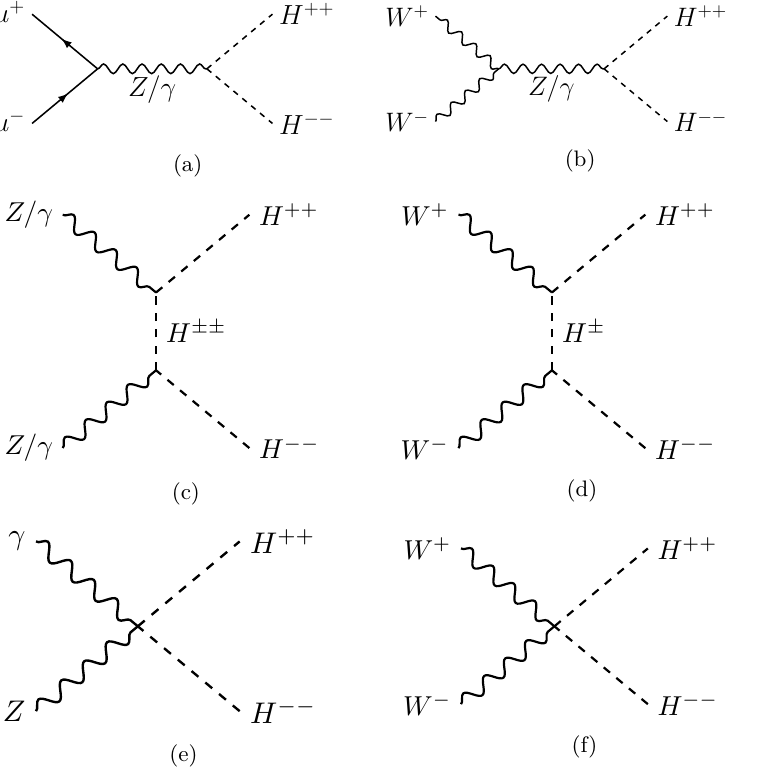
Figure 6 . Feynman diagrams of heavy doubly charged Higgs pair productions in Type II Seesaw. The diagram (a) is the µµ annihilation process ( µ + µ − → H ++ H −− ) and the others are though VBF processes ( V V → H ++ H −−